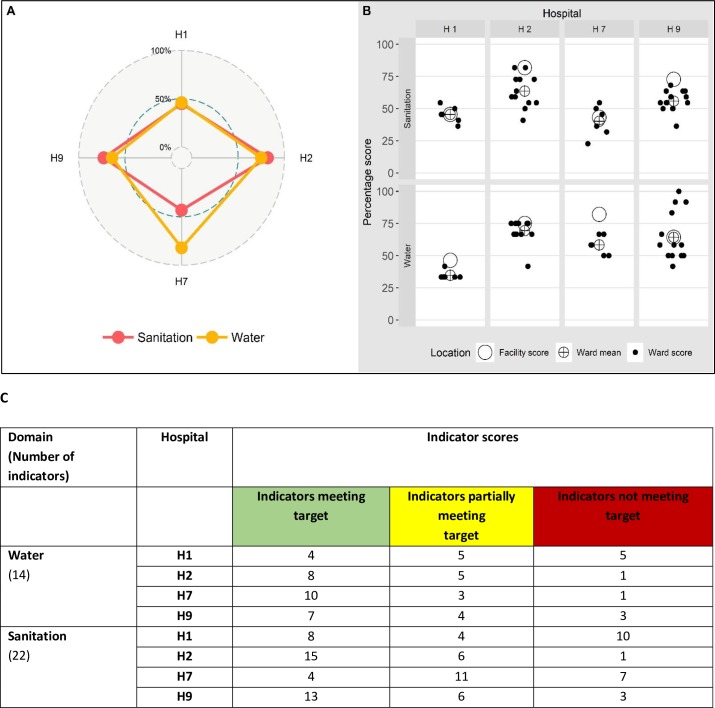
Service performance variation by ward and hospital and the original WASH FIT scores.Panel A: Radar Plot of facility-level scores from four hospitals for two domains (Water, Sanitation) showing similar performance for sanitation overall but more marked variation for water varying hospital performance. Panel B: Shows ward domain scores from multiple wards (dots) for two domains (water, sanitation) illustrating their variation, the mean of these ward-specific scores (circled cross) and the overall facility aggregate score(plain circle). The overall facility score includes assessment of inpatient wards and other service areas (kitchen, outpatient, outdoor environment) across the hospital. Panel C shows WASH-FIT facility-level scores of four hospitals for the two domains.